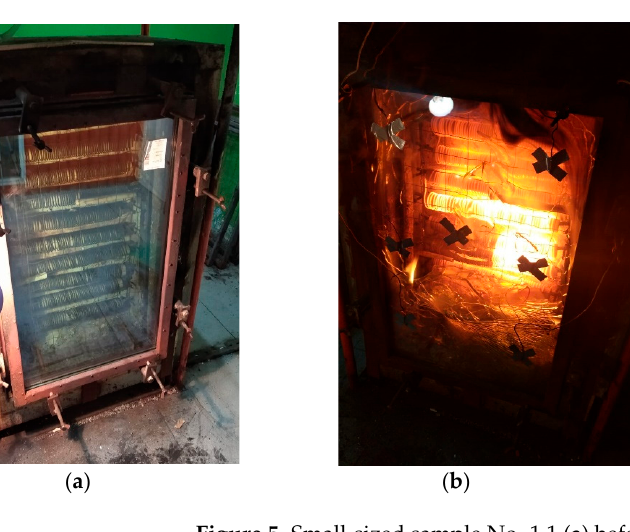
Figure 5. Small-sized sample No. 1.1 ( a ) before, ( b ) in the process and ( с ) after the fire impact. Photo by the